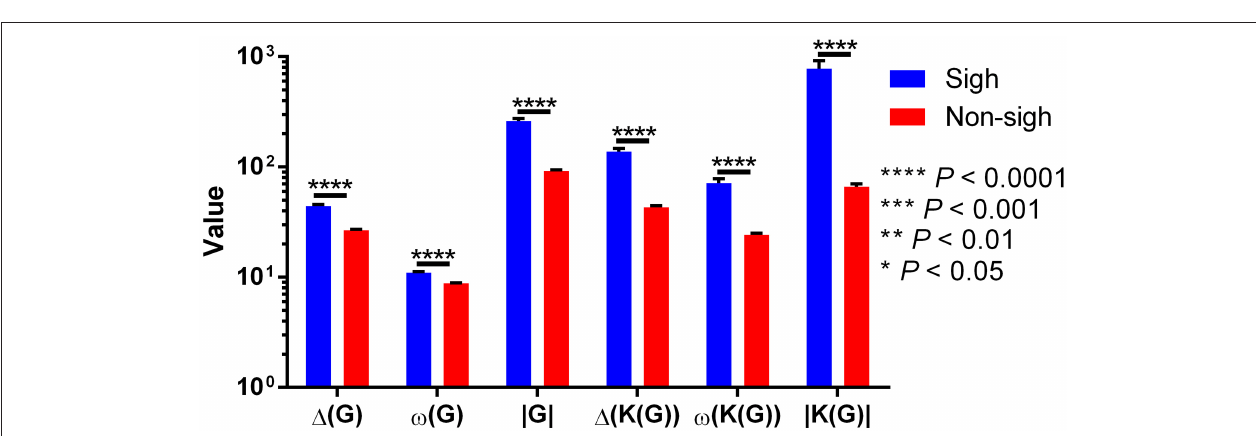
FIGURE 9 | Inspiratory burst classification according with clique’s parameters in Maxclique graph. (A) Control with 39 inspiratory burst and (B) bombesin with 99 inspiratory burst. In red are shown the means of all inspiratory bursts classified.